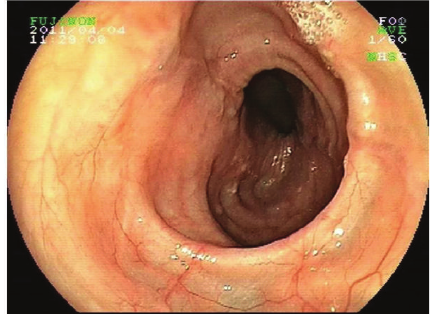
Figure 2: Gastroscopy showing dilated and tortuous oesophagus.